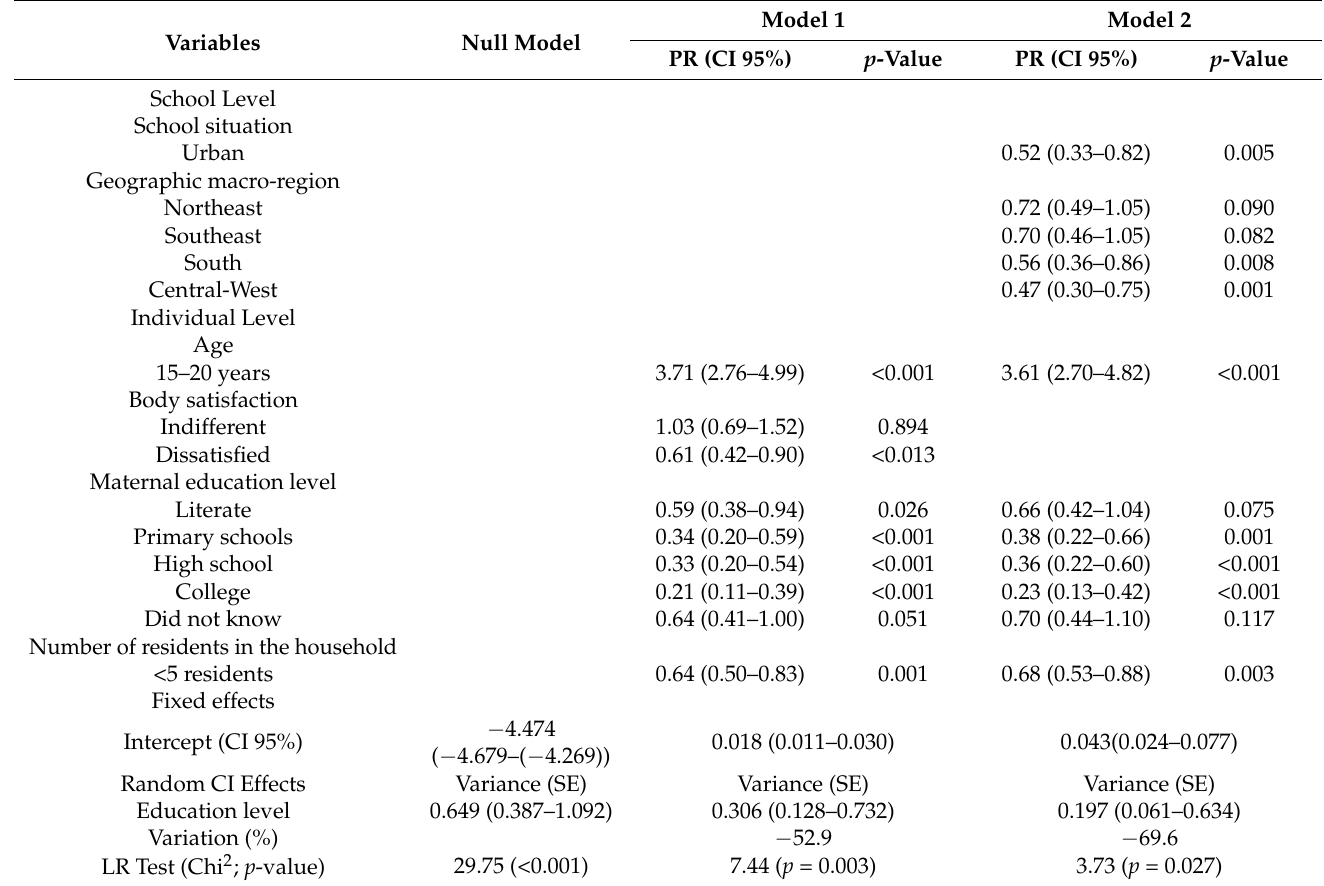
Table 4. Multilevel regression of stunting among Brazilian adolescents and individual- and school- level variables, National School Health Survey,